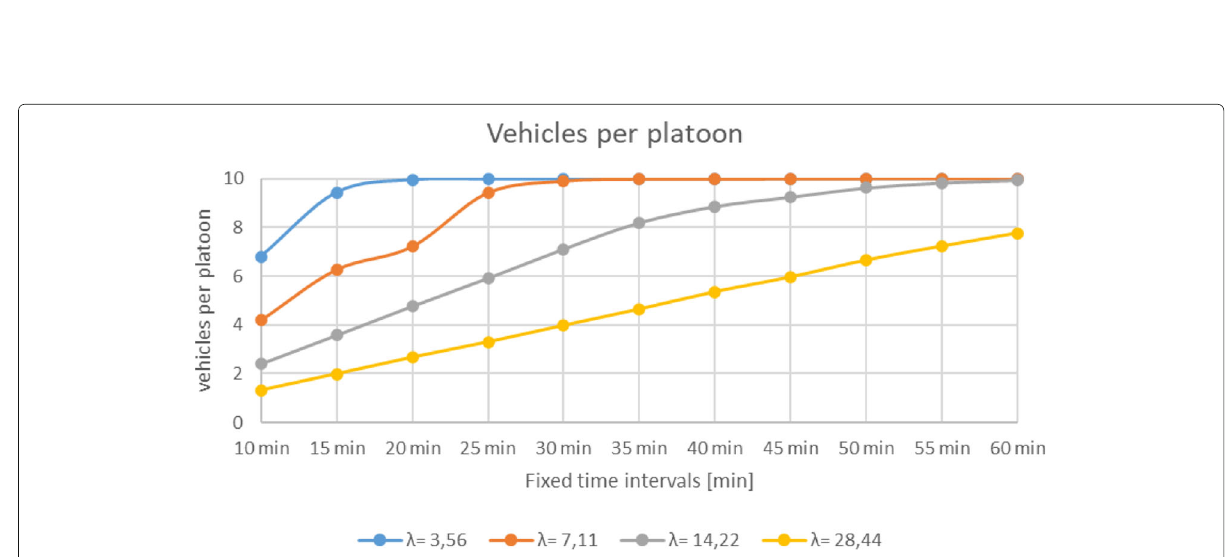
Fig. 11 Compare the number of vehicles per